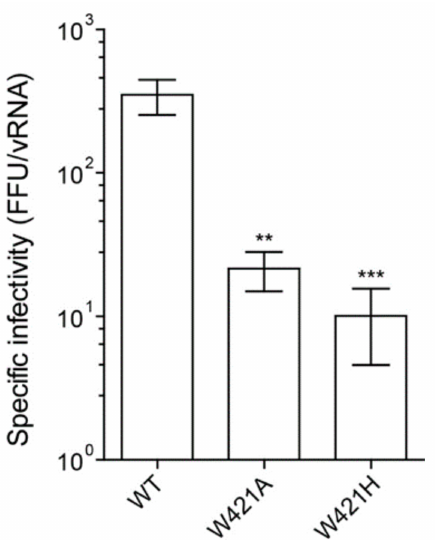
Figure 3. Infectivity of WT and stem mutants. Specific infectivities are indicated as number of focus forming units (FFU) per 10E7 RNA copies. Data are from at least three independent experiments; error bars represent the standard errors of the means (SEM). Asterisks indicate significant differences relative to the WT (ANOVA and Dunnett’s multiple comparison test ** p < 0.01, *** p <